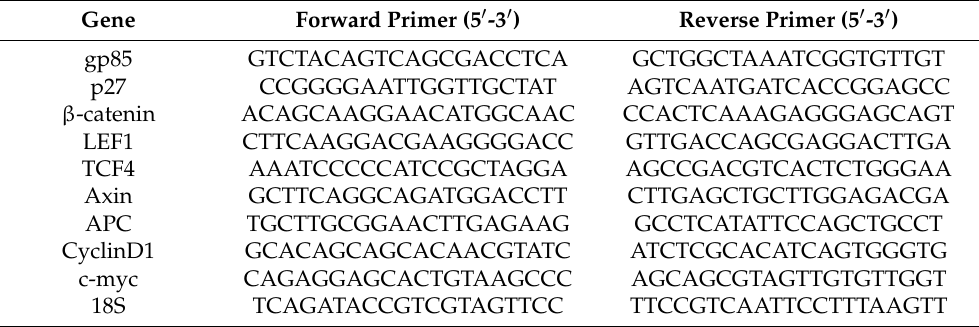
Table 1. Real-time PCR primer